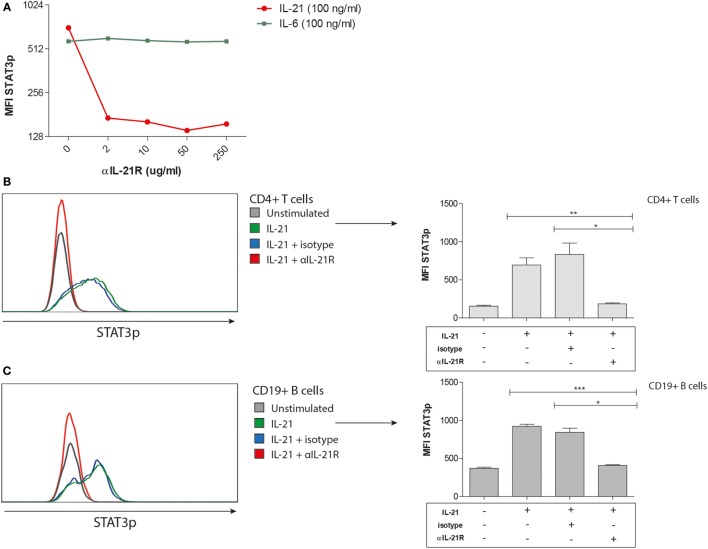
Phosphorylation of STAT3 is inhibited in the presence of αIL-21R antibodies. (A–C) PBMCs were stimulated with 100 ng/ml IL-21 or 100 ng/ml IL-6 for 15 min in the absence or presence of 10 μg/ml αIL-21R or 10 μg/ml IgG1 isotype. median fluorescence intensity (MFI) values of phosphorylated STAT3 were measured directly afterward. (A) Dose–response curve of STAT3p in CD4pos T cells stimulated with 100 ng/ml IL-21 and different concentrations of αIL-21R. Stimulation with 100 ng/ml IL-6 was used as a positive control. (B–C) Histogram overlays and quantified data of phosphorylated STAT3 MFI values in CD4pos T-cells (B) and CD19pos B-cells (C) (n = 7) (*p < 0.05, **p < 0.005, ***p < 0.0005). Upper line of the boxes represent mean with SEM represented by the whiskers.